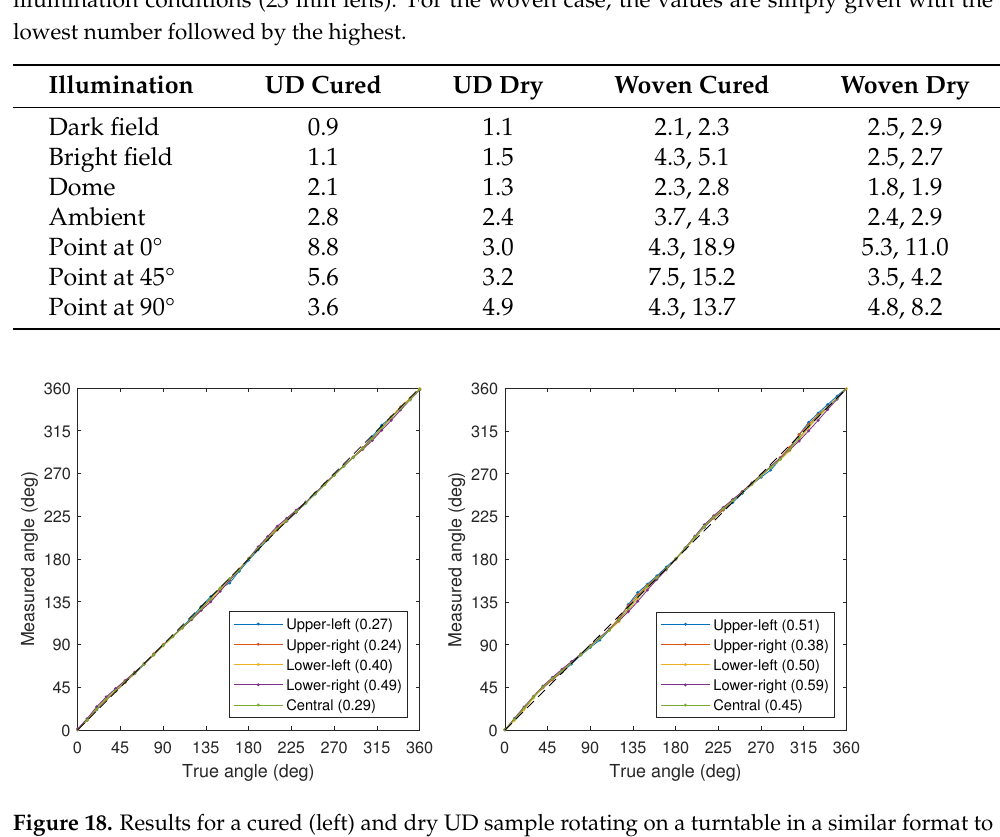
Figure 18. Results for a cured (left) and dry UD sample rotating on a turntable in a similar format to that shown in Figure 8 but with a point source